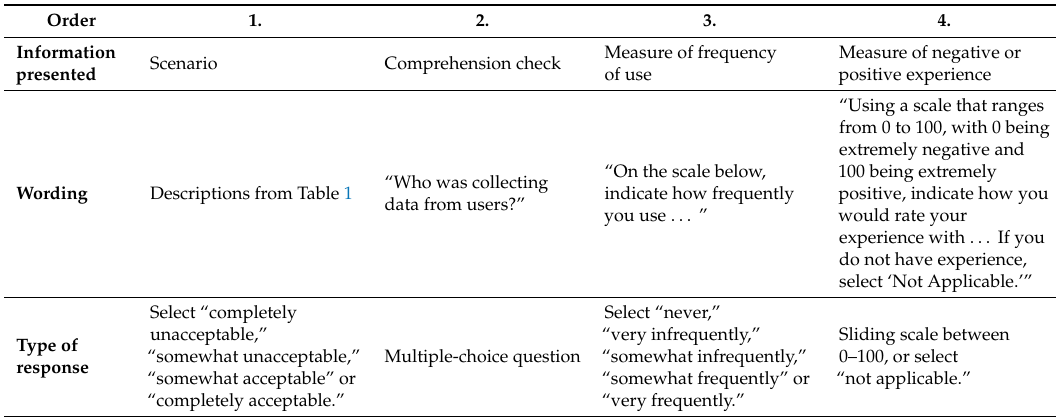
Table 2. Scenarios and follow-up questions (repeated for each